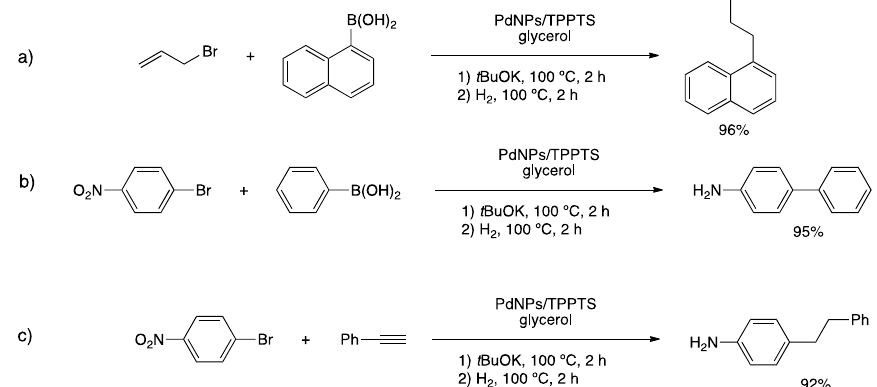
Figure 10. Synthesis of PdNPs in glycerol stabilized by different ligands: TPPTS ( a ) and PTA ( b ) [122,123]. Reproduced from [122] with permission from Wiley and from [123] with permission from Elsevier.